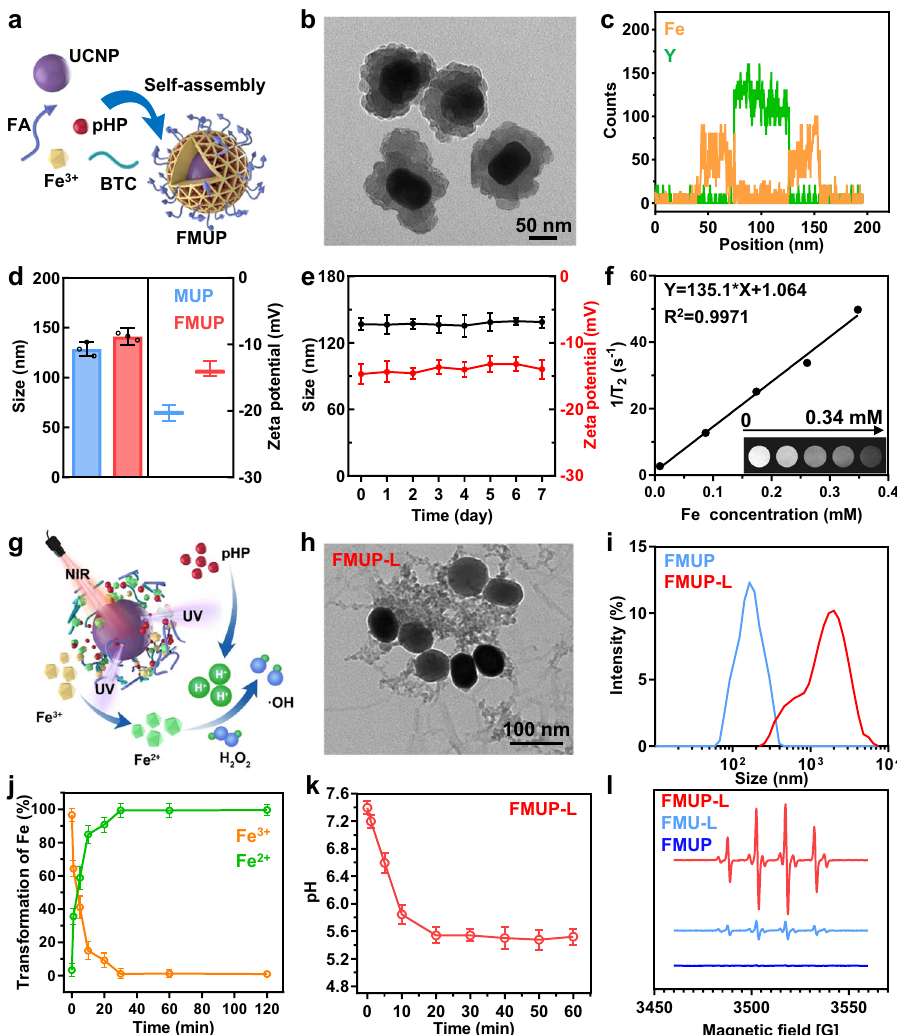
Fig. 2 Characterizations of FMUP. a Schematic illustration of the construction of FMUP by one-pot self-assembly strategy. b TEM image of FMUP. c The distribution of Fe element and Y element in FMUP. d Size and zeta potential of FMUP and MUP dispersed in water. e The stability of FMUP in cell culture medium. f T 2 relaxation rate (1/T 2 , s − 1 ) linearity curve and corresponding T 2 -weighted MRI images of FMUP with different Fe concentrations. g Schematic illustration of nanoagents in response to NIR light irradiation. h TEM image of FMUP after NIR irradiation (980 nm, 1.0 W/cm 2 , 5 min). i Size distribution of FMUP dispersed in water before and after NIR irradiation (980 nm, 1.0 W/cm 2 , 5 min). j The transformation of Fe 3 + to Fe 2 + in FMUP upon continuous NIR irradiation (980 nm, 1.0 W/cm 2 ). k Evolution of pH value of the FMUP suspension sample in PBS upon continuous NIR irradiation (980 nm, 1.0 W/cm 2 ). l ESR spectra of various groups. The acid microenvironment could accelerate the Fenton reactions for generating • OH species. Data in ( d ), ( e ), ( j ), and ( k ) were represented as mean values ± SD, n = 3 biologically independent samples in ( d ), ( e ), ( j ), and ( k ). A representative image of three biologically independent samples from each group is shown in ( b ), ( c ), ( f ), ( h ), ( i ), and ( l pyrroline-oxide (DMPO) as a (cid:129) OH trapping agent for ESR spectral characterization (Fig. 2l). The yield of (cid:129) OH in the FMUP-L group was much higher than that in the FMU-L (the counterpart without photoacid generator) and FMUP groups, again demonstrating the synergistic cooperation between photocontrolled release of Fe 2 + and photoacidi fi cation to reinforce (cid:129) OH production. Similar results were also obtained via a bleaching experiment with methylene blue (MB) (Supplementary Fig. 7). These results together indicated the good ability of FMUP to respond to NIR light as well as the favorable outcomes for (cid:129) OH production. Intracellular fate of FMUP . Owing to the overexpressed folate receptor (FR) on the tumor membrane 37 (Supplementary Figs. 8,